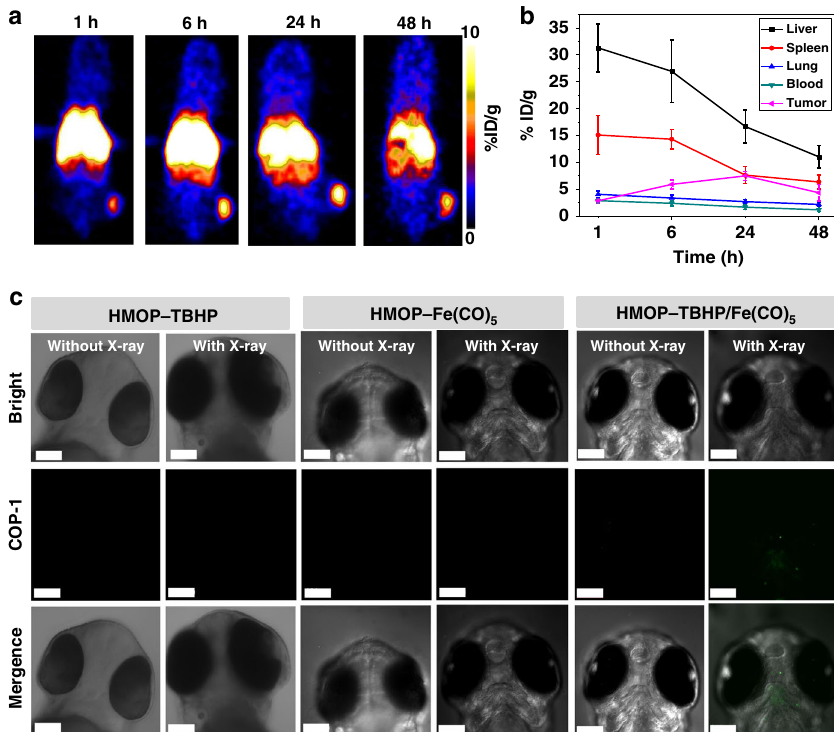
Fig. 8 Biodistribution of HMOP and in vivo X-ray-activated CO release. a PET imaging of U87MG tumor bearing mice at 1, 6, 24, and 48 h after intravenous injection of 64 Cu-labeled HMOP. b Biodistribution of HMOP in liver, spleen, lung, blood, and tumor at 1, 6, 24, and 48 h post-injection of 64 Cu-labeled HMOP. n = 5, mean ± s.d. c Confocal fl uorescence imaging of CO generation in living zebra fi sh larvae with brain microinjection of HMOP-TBHP, HMOP-Fe (CO) 5 , and HMOP-TBHP/Fe(CO) 5 with or without 6 Gy of X-ray irradiation, respectively. CO was monitored using a fl uorogenic COP-1 probe. Scale bar: 120 μ